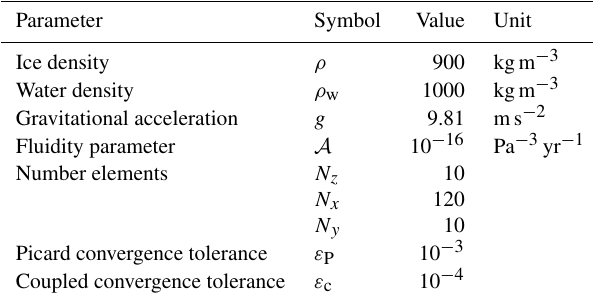
Table A1. Numerical values of the constants used in the ice shelf ramp experiment. Since the shelf is afloat, there is no sliding at the base.